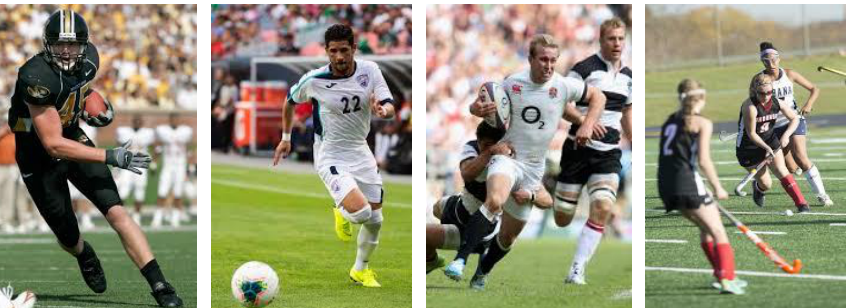
Figure 2. Sample images from the dataset. We can see that the four sports disciplines are indeed very similar in